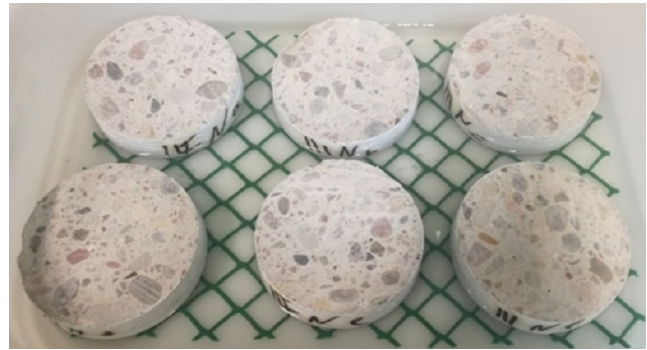
Figure 2. Concrete samples during sorption test.